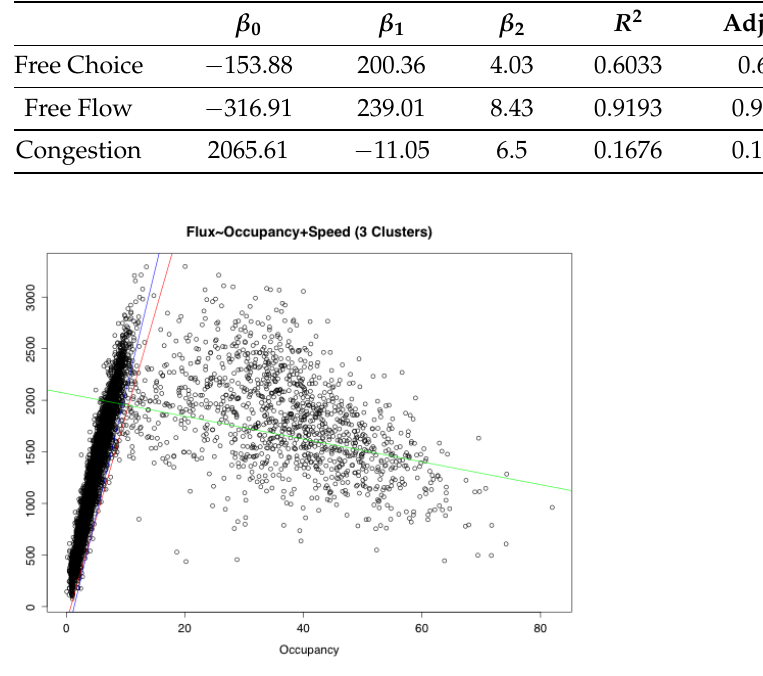
Figure A10. Flux vs. occupancy + speed: RSS analysis. Table A6. RSS